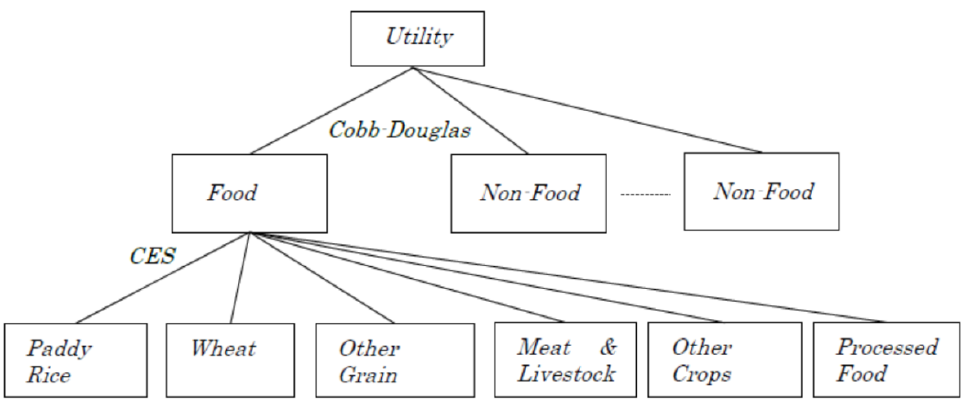
Figure 3. Structure of household consumption.